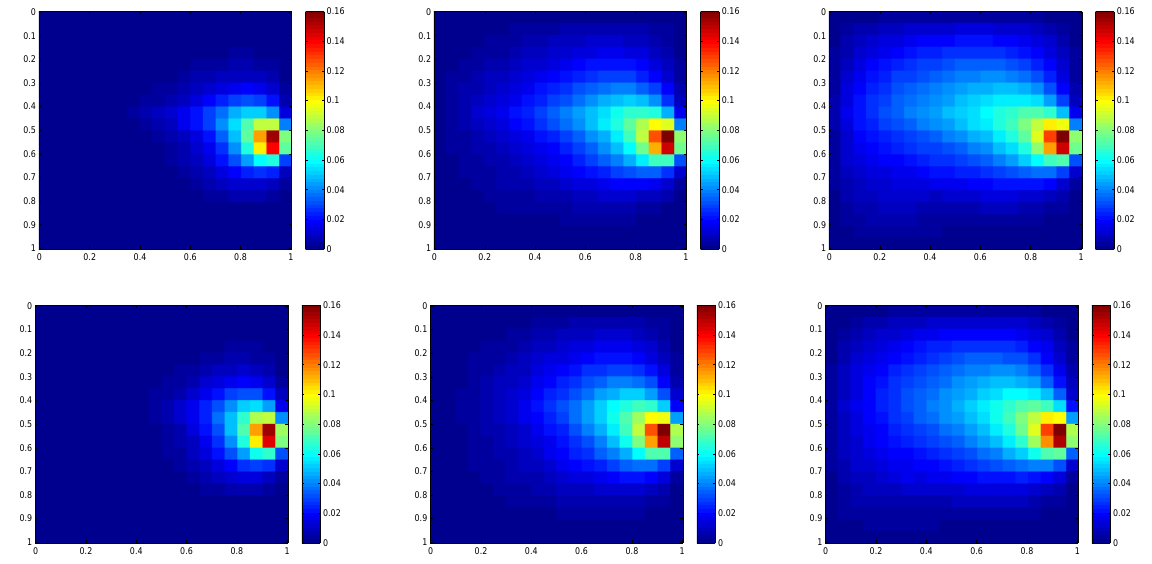
Figure 6. First row: Fine-scale solutions c multiscale basis function per edge for both velocity and flux-concentration). From left column to right column: T = 0 . 015 , 0 . 04 , 0 . 1 . We use κ = ( c 2 + 0 . 2(1 − c ) 2 ) κ H = 1 / 20 . Time-dependent velocity